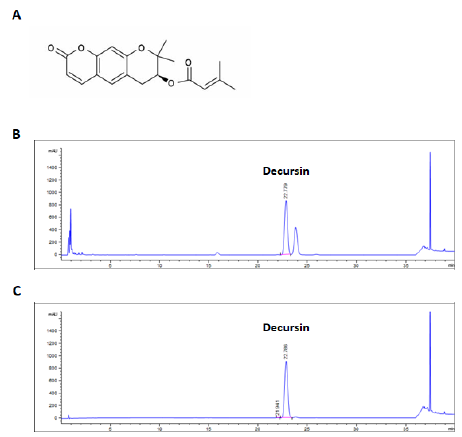
Figure 1. ( A ) Chemical structure of decursin. Ultra-performance liquid chromatography (UPLC) chromatograms of Angelica gigas Nakai ethanol extract ( B ) and the standard decursin ( C ).